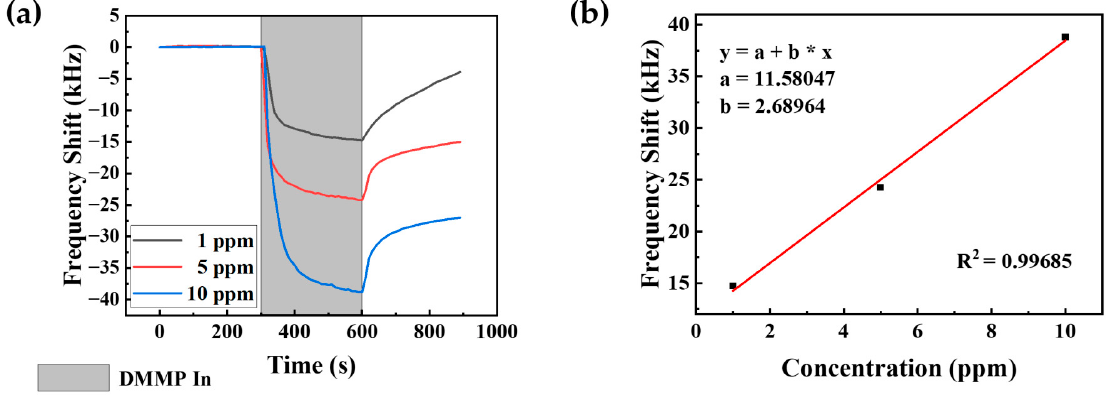
Figure 8. DMMP response from SAW sensors with PSS-TU3. ( a ) DMMP experiments at various concentrations. ( b ) Linearity according to DMMP reaction of various concentrations.